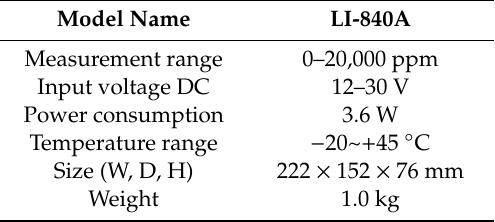
Table 2. Major specifications of the unmanned aerial vehicle (UAV).